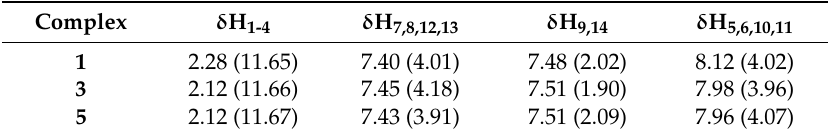
Figure 1. Numeration of protons for zinc complexes. Table 2. Chemical shifts in 1 H NMR spectra of the hydrogen atoms in complexes 1 , 3 , and 5 , ( n ) = Integral values. (See Figure 1.)